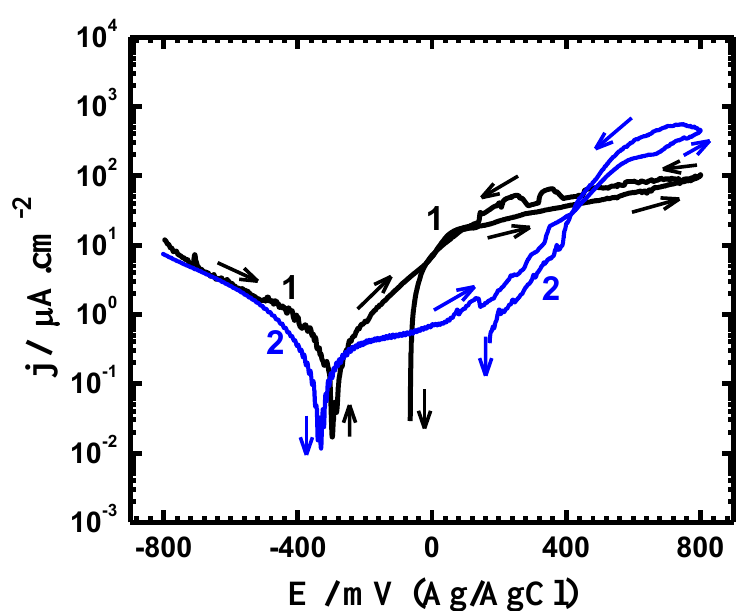
Figure 3. The polarization curves obtained for (1) Ti-6%Al and (2) Ti-6%Al-4%V alloys after their immersions in the chloride solution for 24 h.